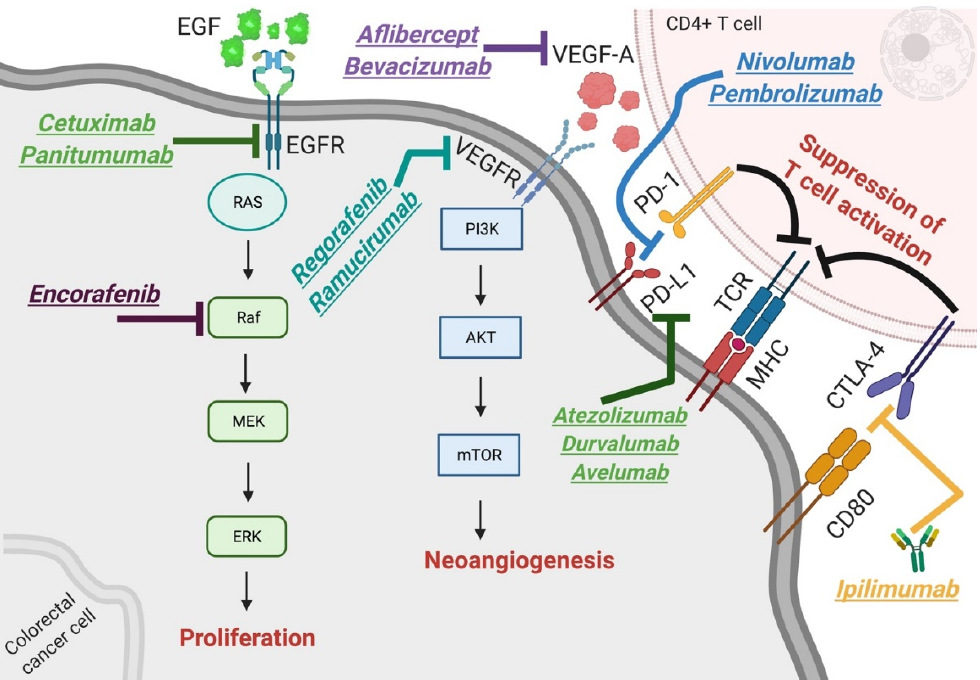
Figure 2. Molecular mechanisms of targeted drugs approved by the Food and Drug Administration for the treatment of metastatic colorectal cancer. (1) Anti-EGFR (epidermal growth factor receptor) monoclonal antibodies (mAbs) cetuximab and panitumumab; (2) encorafenib, an inhibitor of the Raf protein as part of the MAPK/ERK signaling pathway; (3) VEGF-A (vascular endothelial growth factor-A) inhibitors aflibercept and bevacizumab; (4) VEGF receptor inhibitors regorafenib and ramucirumab; (5) anti-PD-1 (programmed cell death-1) mAbs nivolumab and pembrolizumab and anti-PD-L1 (programmed cell death ligand 1) mAbs atezolizumab, durvalumab and avelumab; (6) anti-CTLA-4 (cytotoxic T lymphocyte-associated antigen-4) mAb ipilimumab. Current targeted therapies inhibit three major processes crucial for cancer growth: unrestricted proliferation, neo-angiogenesis and suppression of T cell immune responses.